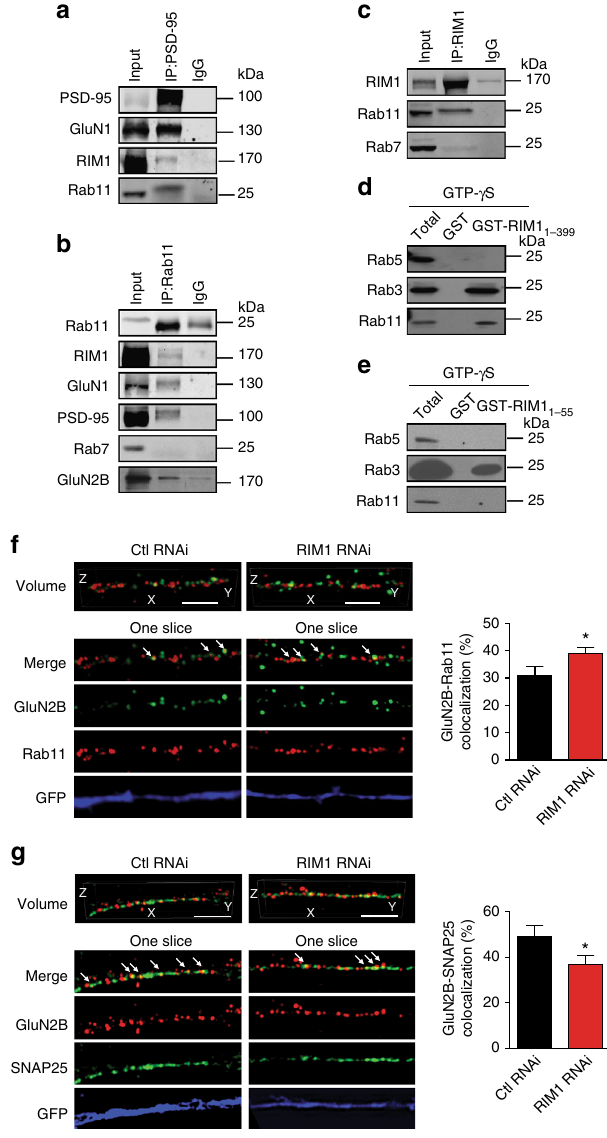
Fig. 8 RIM1 acts as an effector of Rab11 and participates in the recycling of NMDARs. a – c Rab11 is involved in the RIM1/PSD-95/NMDAR complex in mouse cortex. Extracts of mouse cortex were immunoprecipitated with antibody against PSD-95, Rab11, or RIM1, and blotted with the corresponding antibodies. d GST-RIM1 1-399 interacts directly with Rab3 and Rab11, but not with Rab5, in the presence of GTP- γ S. e GST-RIM1 1-55 has a direct interaction with Rab3, but not with Rab5 or Rab11, in the presence of GTP- γ S. f RIM1 KD signi fi cantly increases the colocalization of Rab11 and GluN2B. Left: cultured hippocampal neurons were transfected with control RNAi ( n = 23 neurons from three independent cultures) or RIM1 RNAi ( n = 32 neurons from three independent cultures) plasmids at DIV6 and were then co-immunostained with antibodies against GluN2B and Rab11 at DIV10 and imaged by 3D-SIM. The lower four lines ( “ one slice ” ) show one of the Z slices. Scale bar, 3 µ m. Right: statistical analysis of colocalization of GluN2B and Rab11; t -test, * p < 0.05. g RIM1 KD signi fi cantly decreases the colocalization of SNAP25 and GluN2B. Left panel: cultured hippocampal neurons were transfected with control RNAi ( n = 15 neurons from three independent cultures) or RIM1 RNAi ( n = 12 neurons from three independent cultures) plasmids at DIV6. The neurons were immunostained with antibodies against GluN2B and SNAP25 at DIV10 and imaged by 3D- SIM. The lower four lines ( “ one slice ” ) show one of the Z slices. Scale bar, 3 µ m. Right panel: statistical analysis of colocalization of GluN2B and SNAP25; t -test, * p <